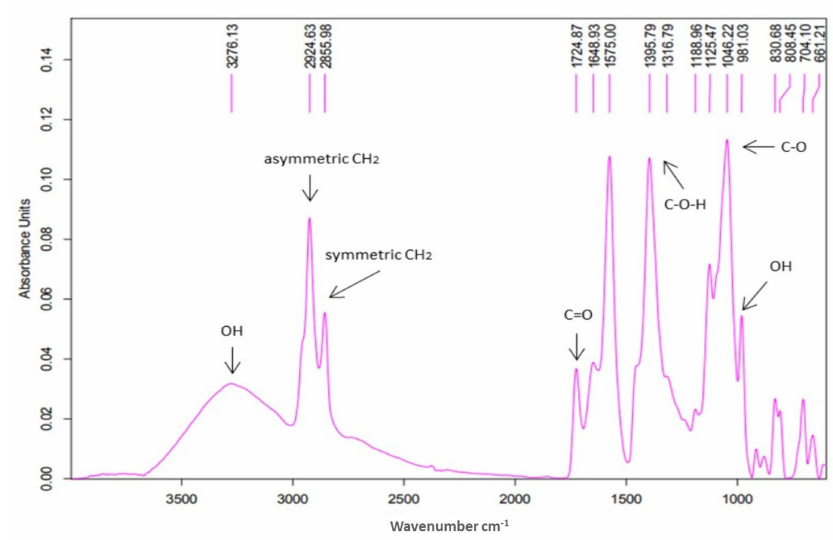
Figure 4. FTIR spectrum of the